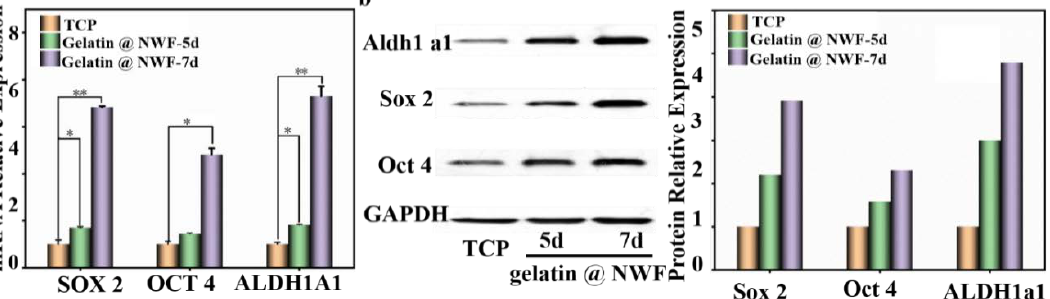
Figure 5. An elevated level of putative CSC markers in cells grown on gelatin@NWF scaffold. ( a ) RT- qPCR characterized relative mRNA expression of OCT4, SOX2, and ALDH1A1 in cells grown on gelatin@NWF scaffold for 5 and 7 days, * denotes p < 0.05, ** denotes p < 0.01; ( b ) Western blot analysis to compare the Sox2 (35 kDa), Oct4 (45 kDa), and ALDH1A1 (55 kDa) level compared to GAPDH (36 kDa) in cells grown on TCP and gelatin@NWF scaffold for 5 and 7 days.